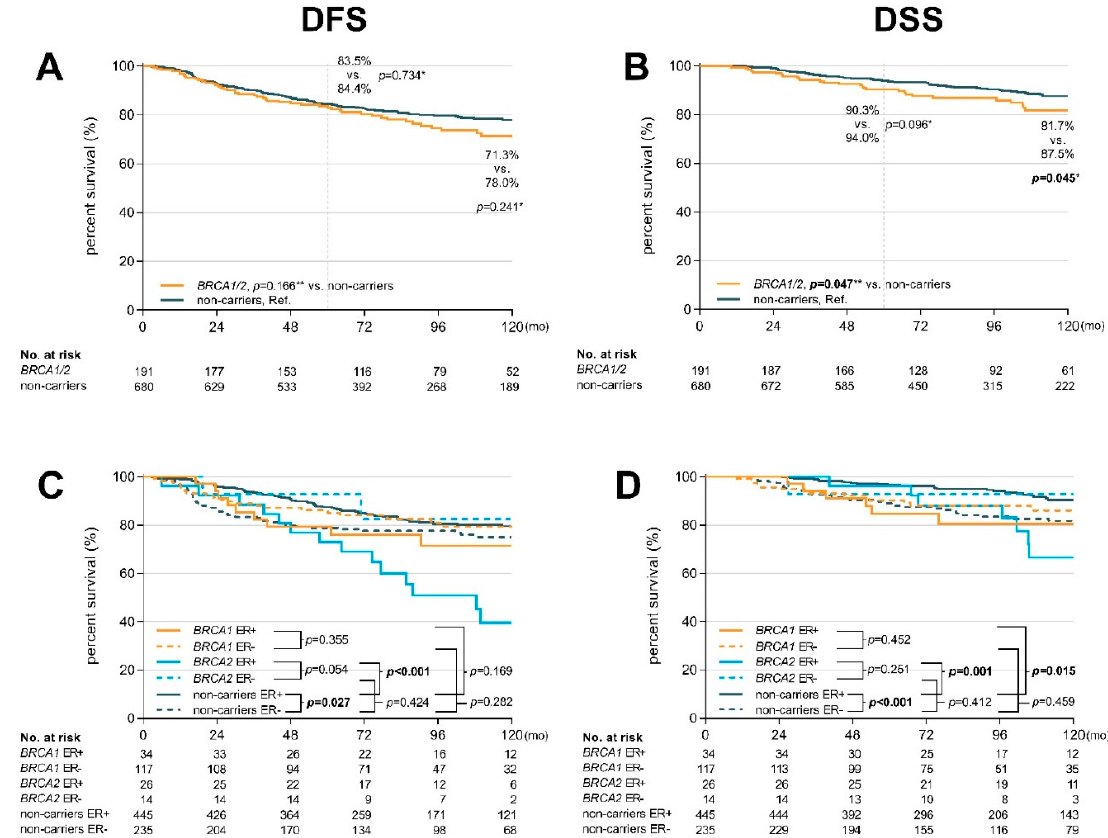
Figure 1. Kaplan-Meier plots showing disease-free survival (DFS) ( A ) and disease-specific survival (DSS) ( B ) in BRCA1 / 2 mutation carriers and non-carriers; DFS ( C ) DSS ( D ) of BRCA1 mutation carriers, BRCA2 mutation carriers, and non-carriers classified according to the ER status. * p -values calculated by χ 2 test (number of events at the end of follow-up interval); ** p -values calculated by log-rank test (considering whole follow-up period).